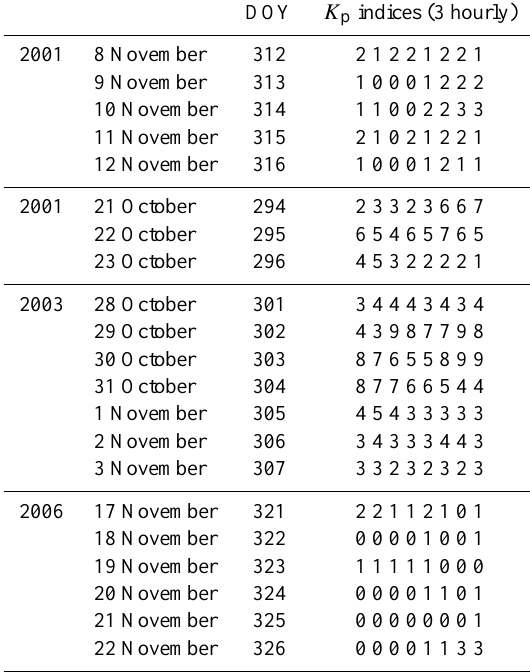
Table 2. Days used in the analyses (given as day-of-year, DOY) and the corresponding 3-hourly K p values for each day such that the first K p value corresponds to midnight 00:00LT.